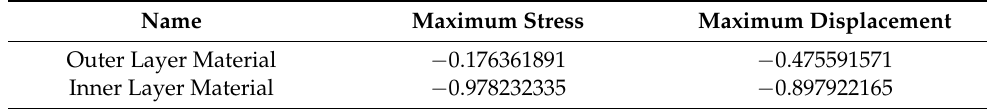
Table 3. Correlation table of first